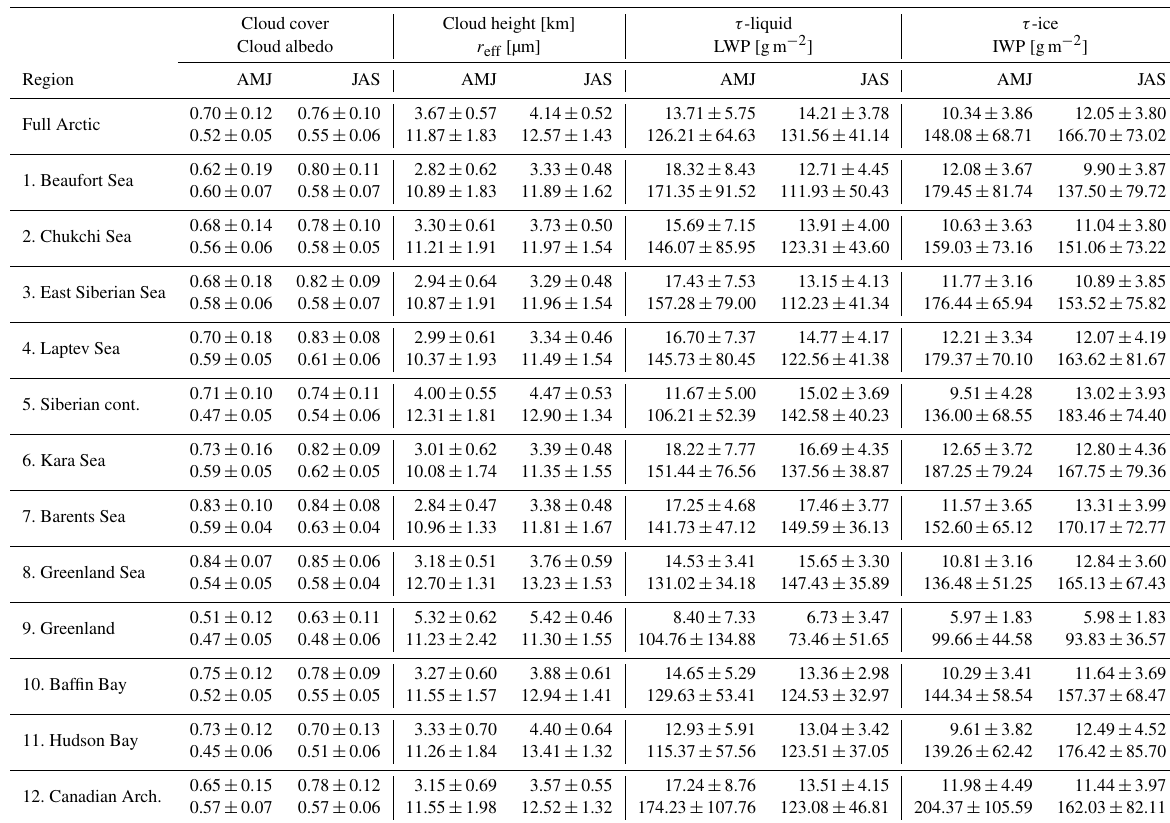
Table G1. Multiyear seasonal means ( ± standard deviation) of cloud properties for the full Arctic and 12 regions of Fig. B1. Cloud cover Cloud height